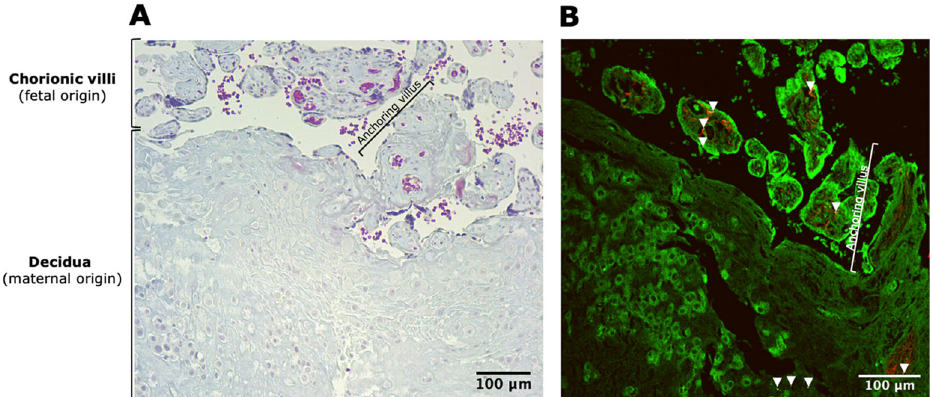
Fig. 1 The term decidual basal plate. A Image from a histological section of a maternally sided placental biopsy stained with Masson ’ s trichrome. The maternally sided biopsies comprise decidual cells (maternal origin) as well as invaded extravillous trophoblasts and trabecular chorionic villi (both of fetal origin); those biopsies are thus composed of both maternal and fetal tissues. B Evidence of carbon particles in the maternally sided biopsy of the human placenta, as analyzed in the published manuscript. White-light generation originating from the carbon particles (white and further indicated using white arrowheads) under femtosecond pulsed laser illumination (excitation 810 nm) is observed in the placental tissue (two-photon excited auto fl uorescence from placental and red blood cells in green and second harmonic generation from collagen in red).